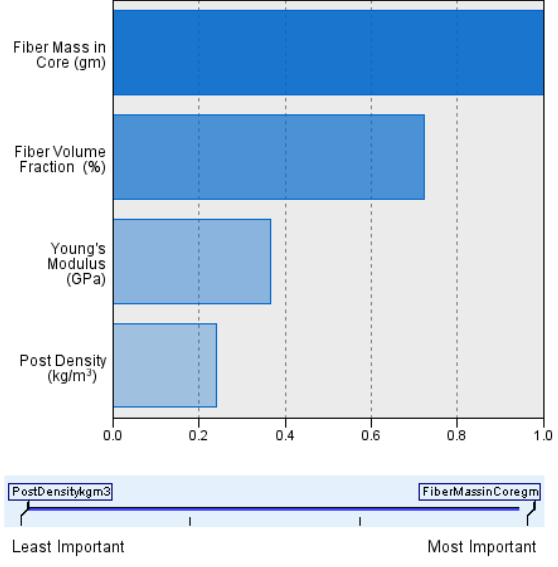
Figure 16. Importance predictor